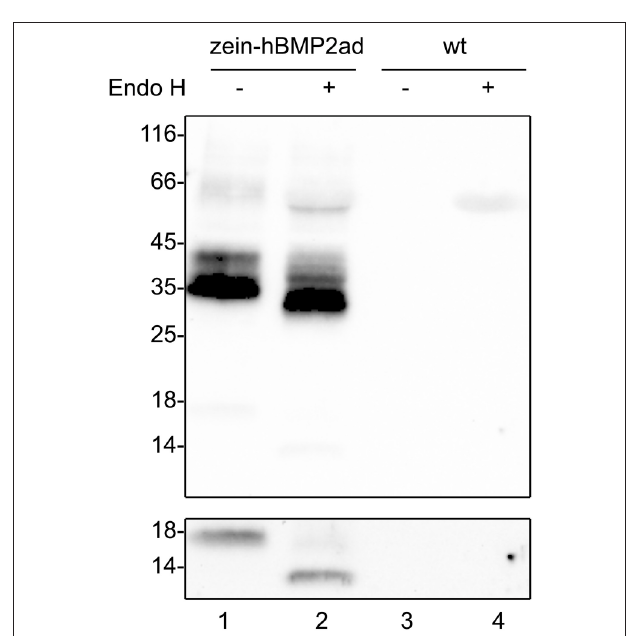
FIGURE 7 | zein-hBMP2ad is N-glycosylated. Eight micrograms of total leaf proteins from zein-hBMP2ad line #7 or from wt plants, extracted in the presence of 2-ME, were incubated with Endo H ( + ) or without enzyme ( − ) as control and analyzed by SDS-PAGE and protein blot with anti-Flag antiserum. Bottom panel: longer exposure of the 14–18 kD portion of the blot. Numbers at left indicate the position of molecular mass markers, in kD.